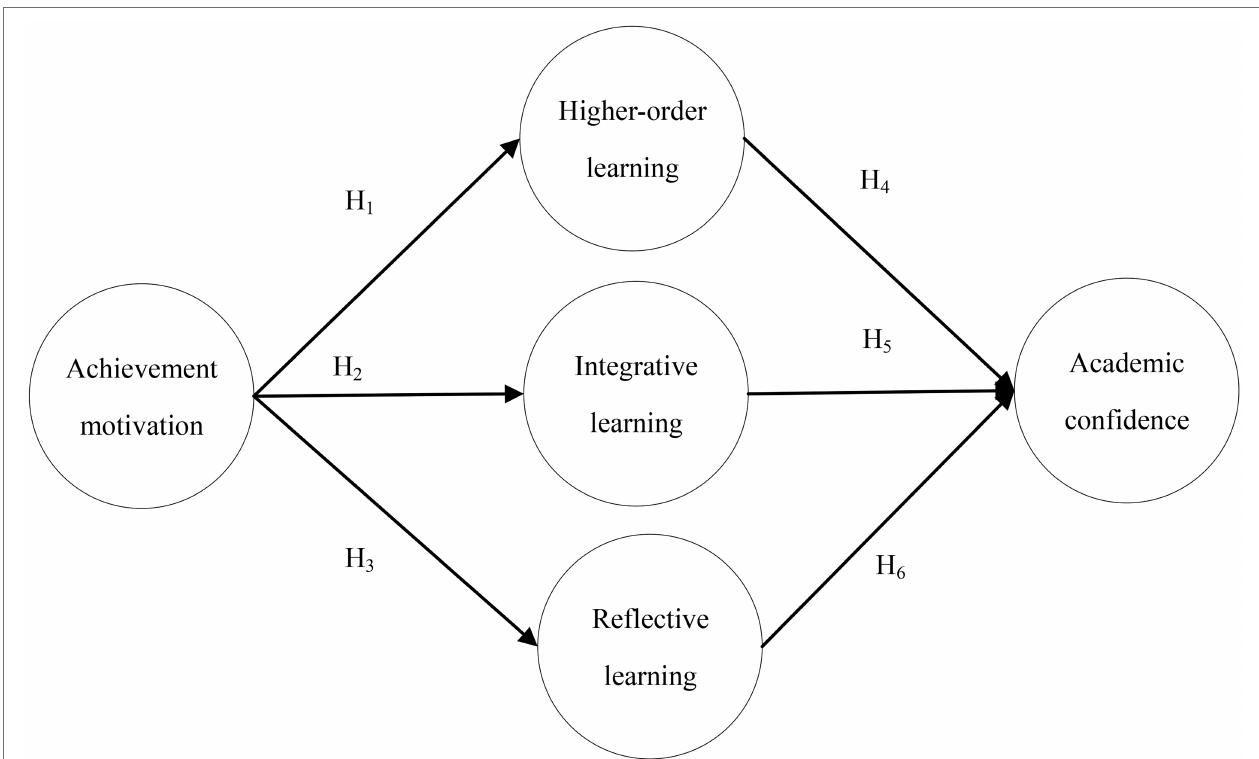
FIGURE 1 | Research model.